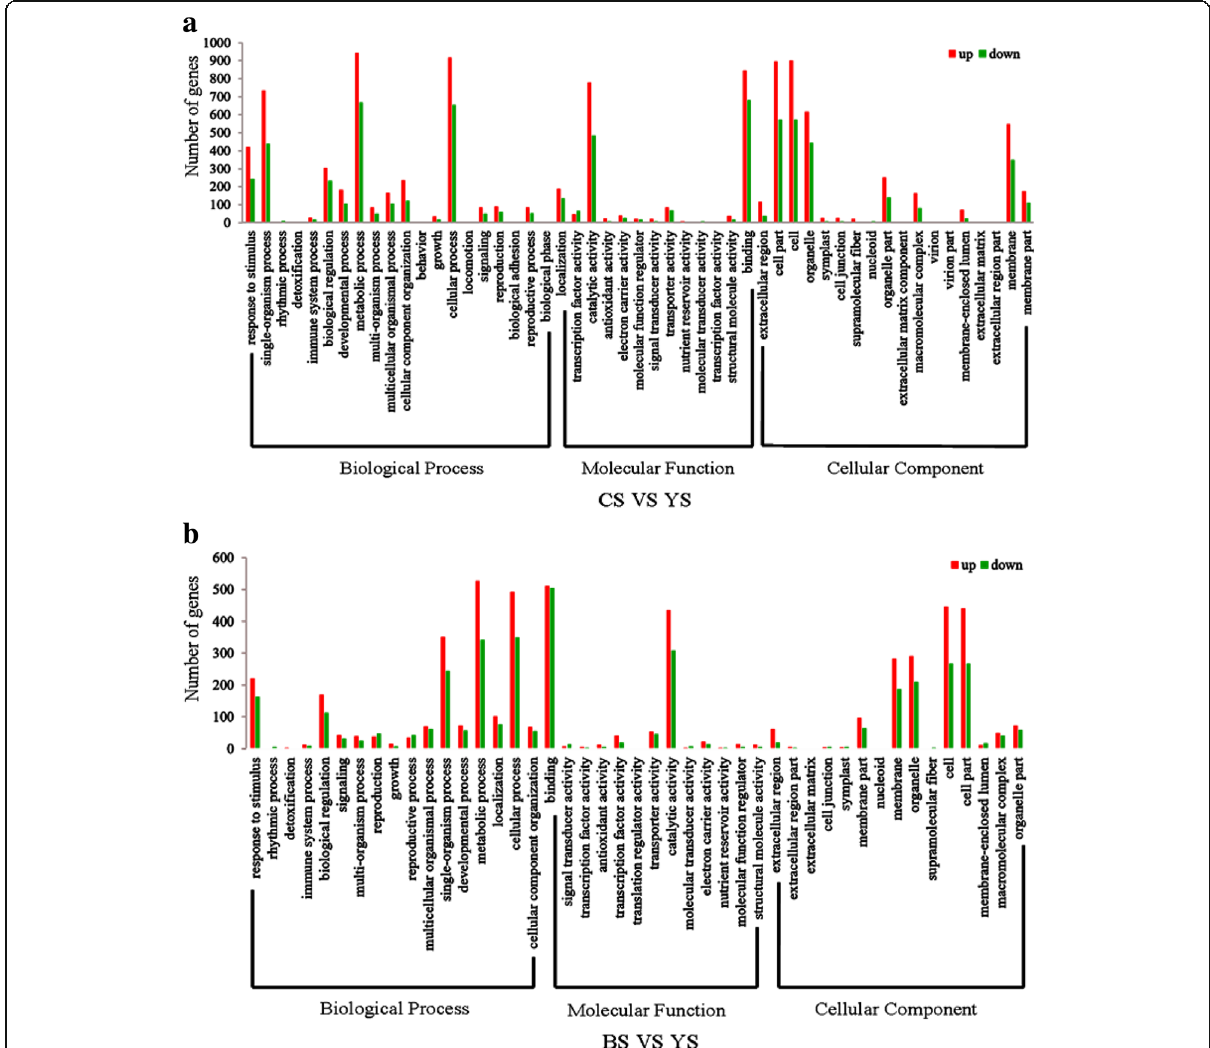
Fig. 6 Comparison of Gene Ontology (GO) classifications of DGHP. a CS and YS represent CHT025 and WFYT025 respectively. Red column and green column represent up-regulated and down-regulated transcripts respectively. b BS and YS represent WFB and WFYT025 respectively. Red column and green column represent up-regulated and down-regulated transcripts